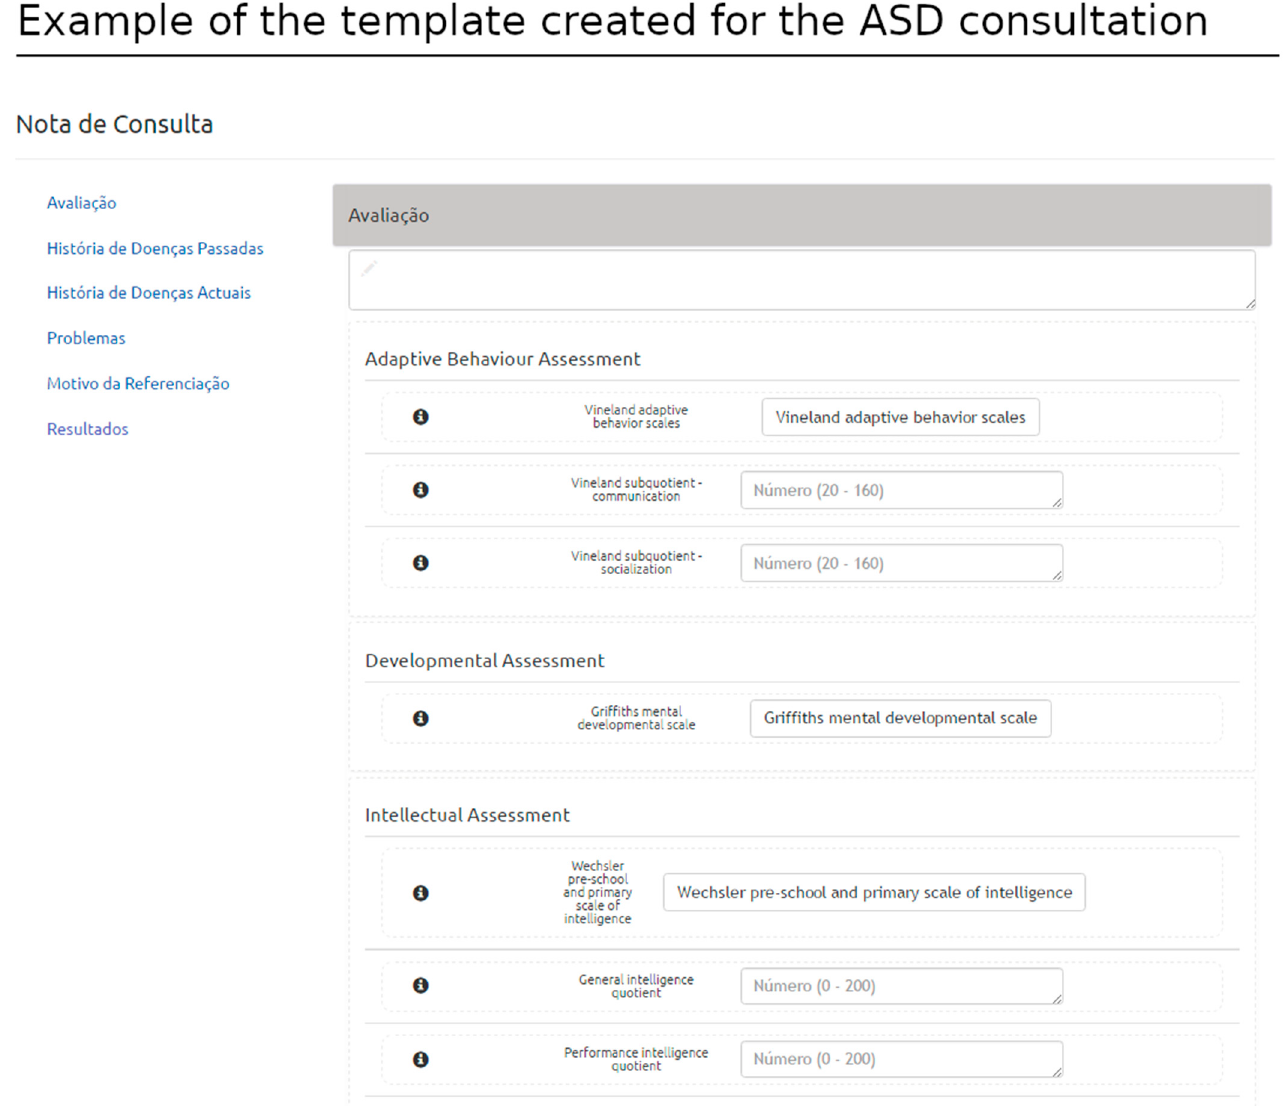
Figure 10. Example of the template created in the context of ASD consultation. Conceptual areas (adaptive behavior assessment, neurodevelopmental assessment, intellectual assessment) organize concepts while defining rules for data entry. (The Portuguese terms have the following translations in English: Nota Consulta: Consultation Note; Avaliação: Assessment; História de Doenças Passadas: History of Past Diseases; História de Doenças Atuais: History of Current Diseases; Problemas: Problems; Motivo da Referência: Reason for Referral; and Resultados: Results).